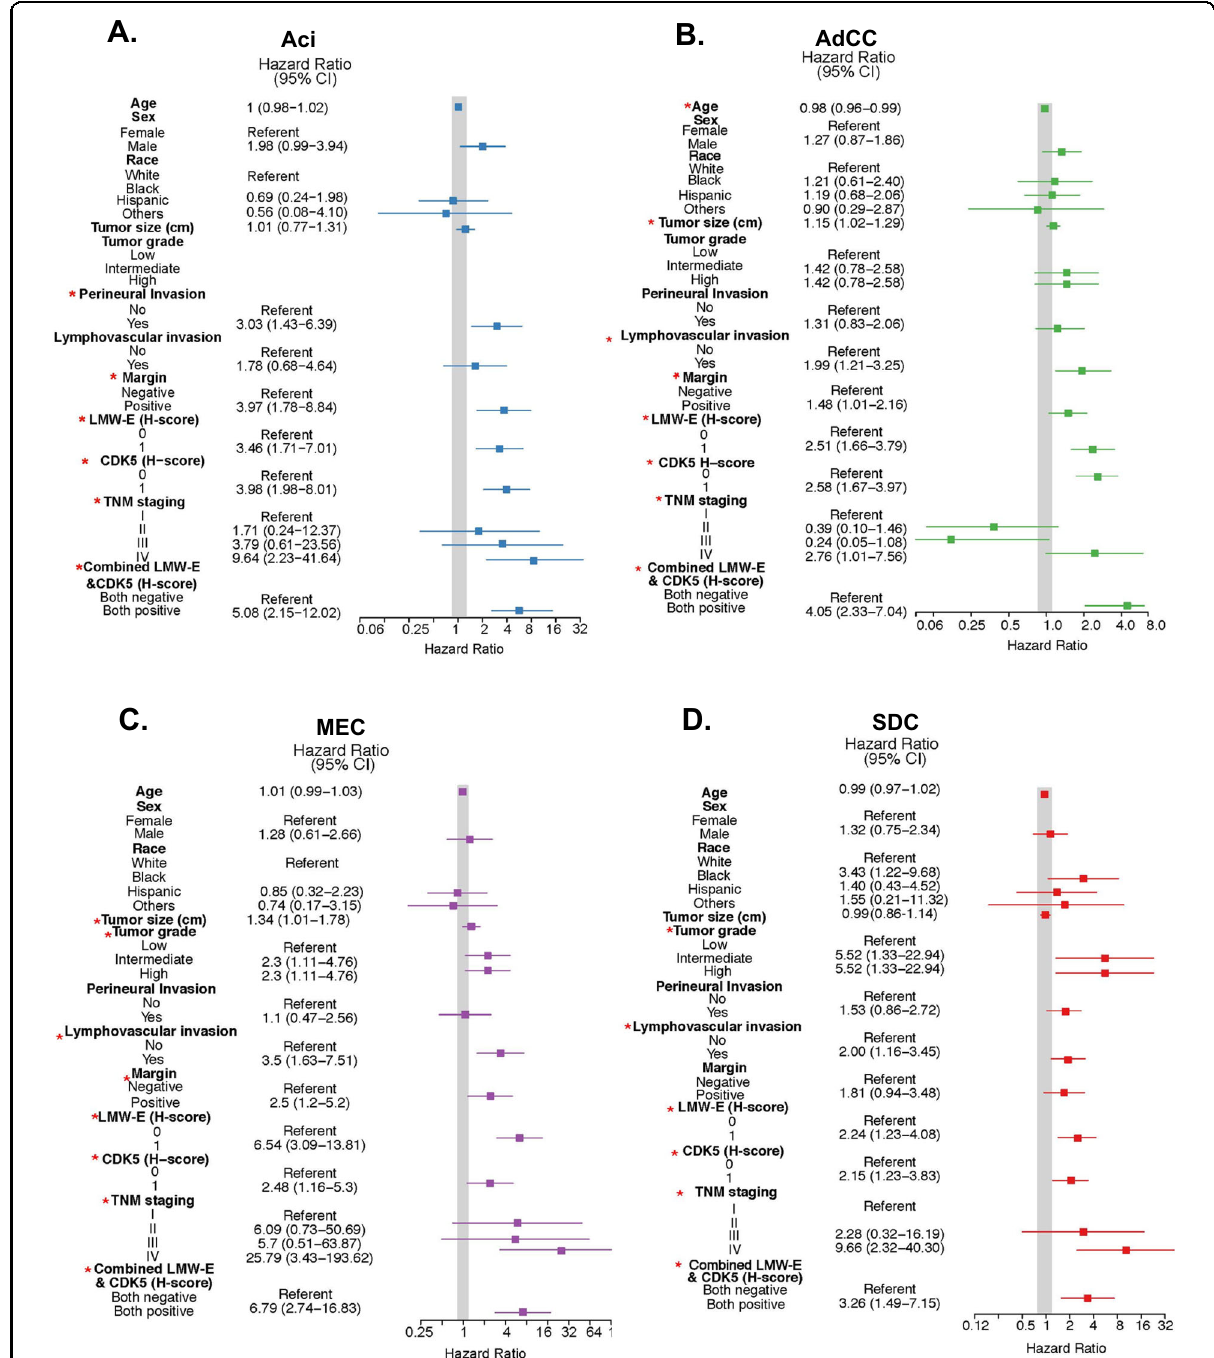
Fig. 5 LMW-E and CDK5 are associated with recurrence-free survival in all subtypes of salivary gland tumors. Forest plots analysis indicating univariable analysis of the indicated variables with recurrence-free survival in each subtype. The solid gray line indicates a hazard ratio of 1 for the overall population. Variables with p values <0.05 are marked with * and are signi fi cant predictors of recurrence-free survival for each subtype, calculated using the Cox proportional-hazards